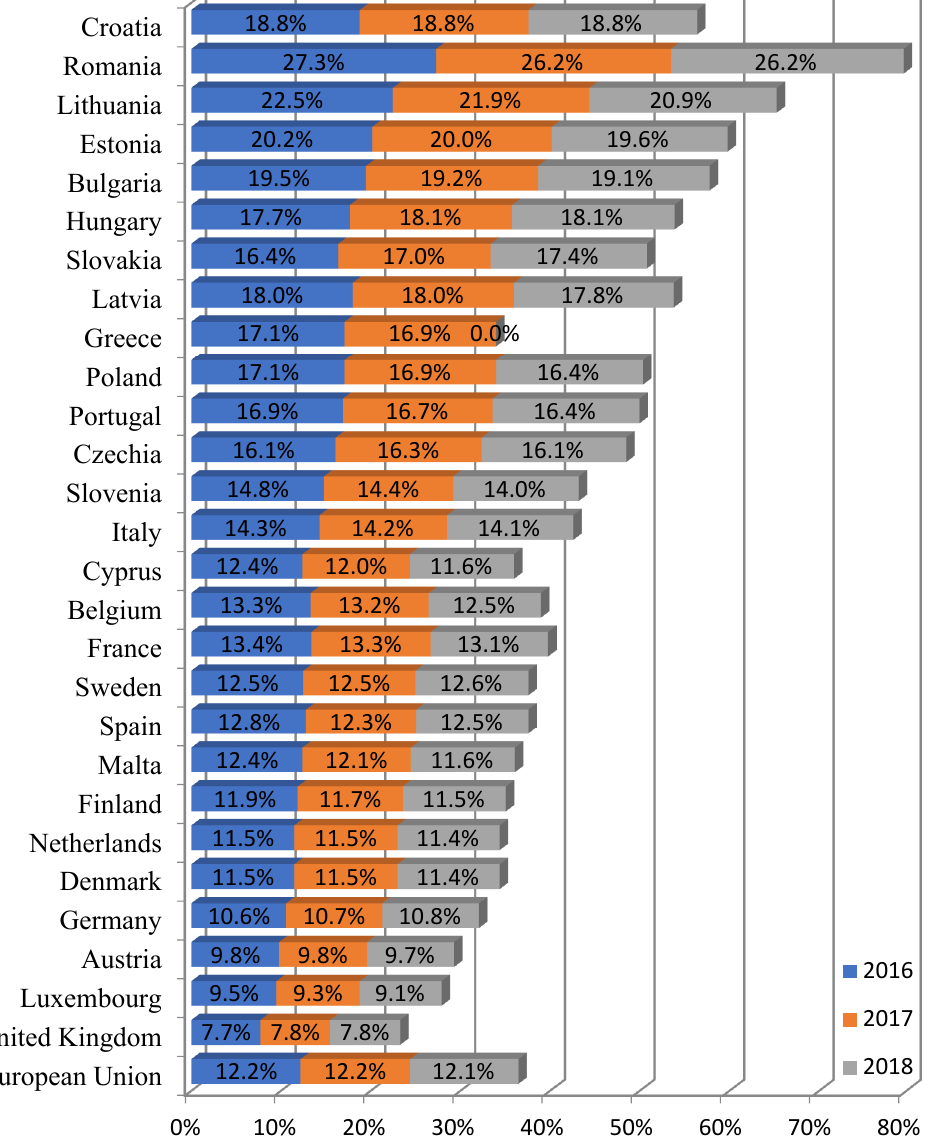
Figure 2. Household expenditure on food and non-alcoholic beverages in the EU in 2016, 2017, and 2018. Source: created by authors according to data from [62].